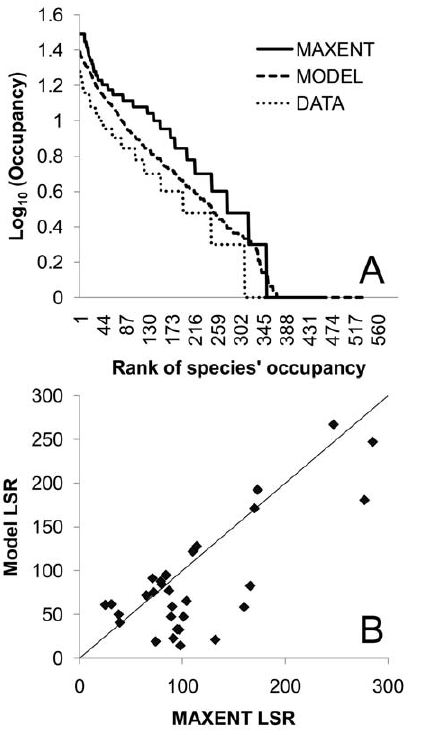
Figure 2. Plots of the model fits to the data used for the analysis. Panel A: rank-occupancy for the empirical freshwater fish data (dotted line), neutral model (dashed line; averaged over 120 simulation runs of the rank-occupancy after 130 generations), and the MAXENT-derived rank-occupancy distribution data (solid line). Panel B: relationship between the local species richness (LSR) from the neutral model (y-axis) and the MAXENT-derived distribution data (x-axes). The solid line is the 1:1 line.